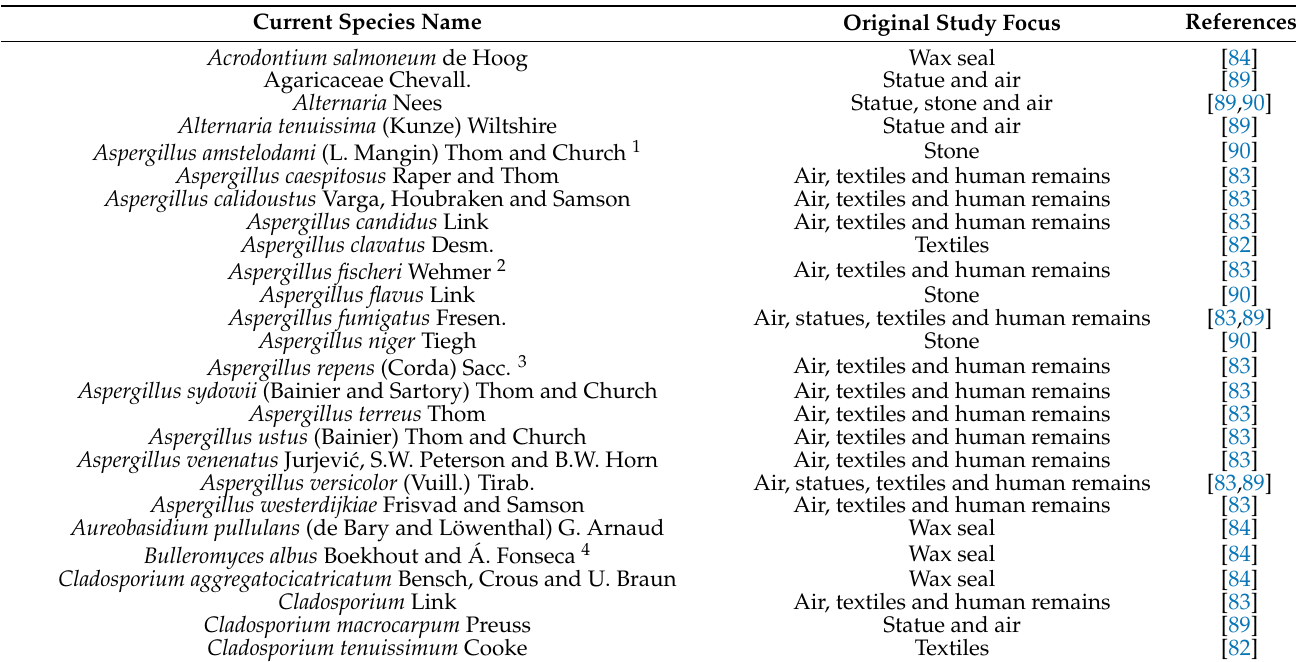
Table 6. Overview of fungal species for which isolates have been identified as displaying estereolytic abilities in biodeterio- rative plate